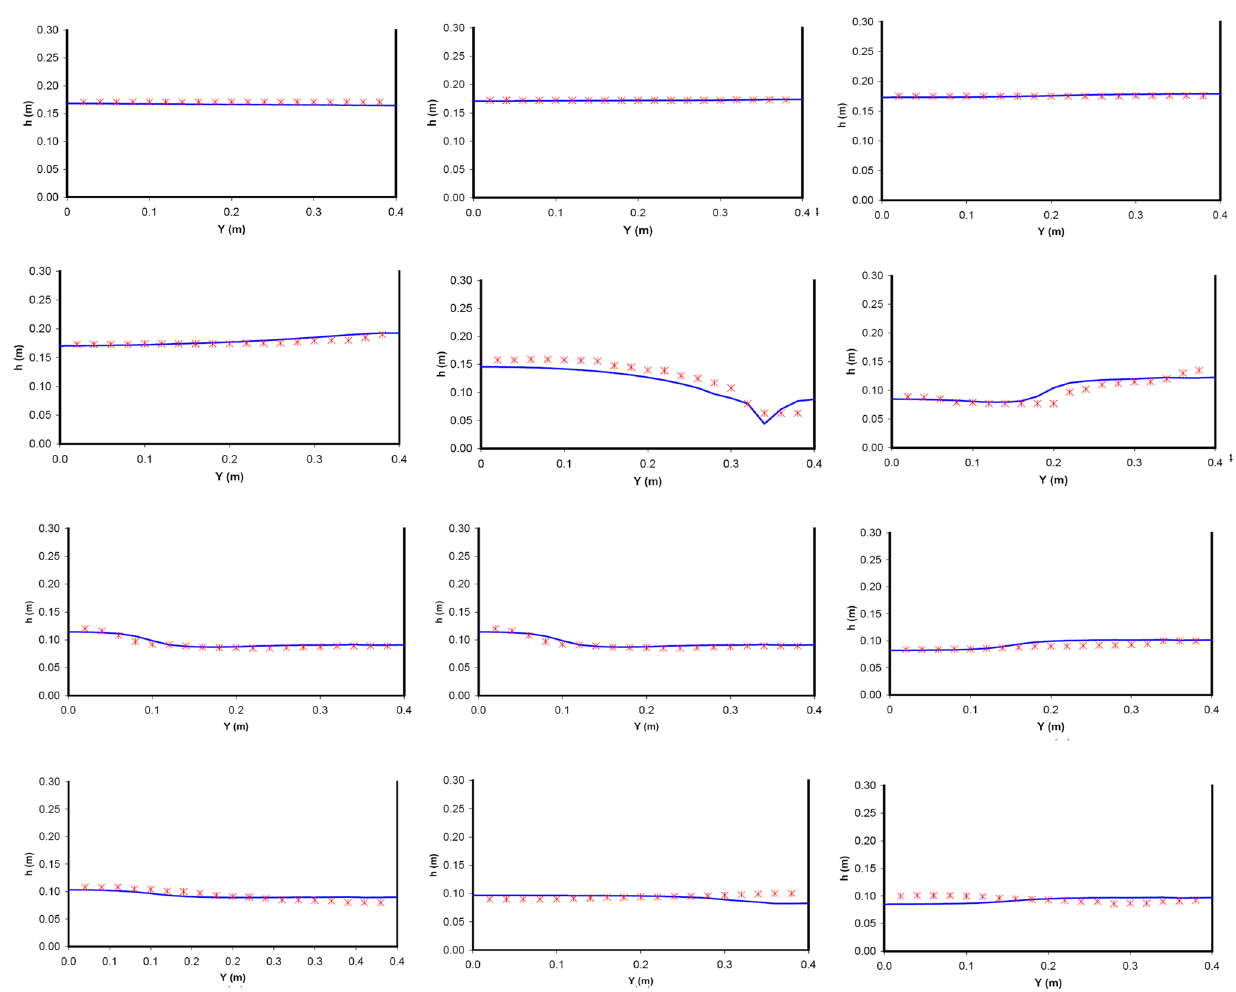
Fig. 8 The latitudinal profiles of flow depths in numerical and experimental results